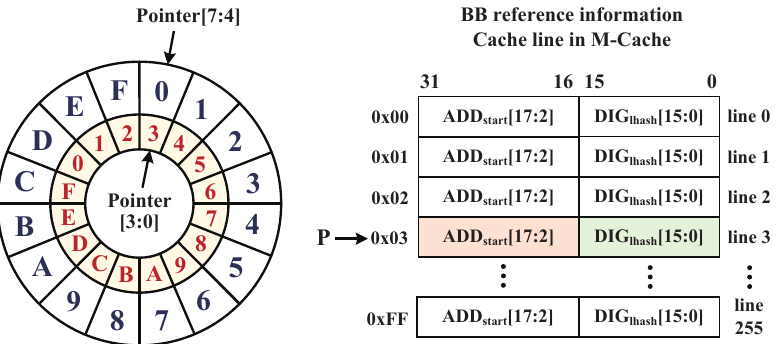
Figure 6. The M-Cache searching method and internal structure of BB reference information